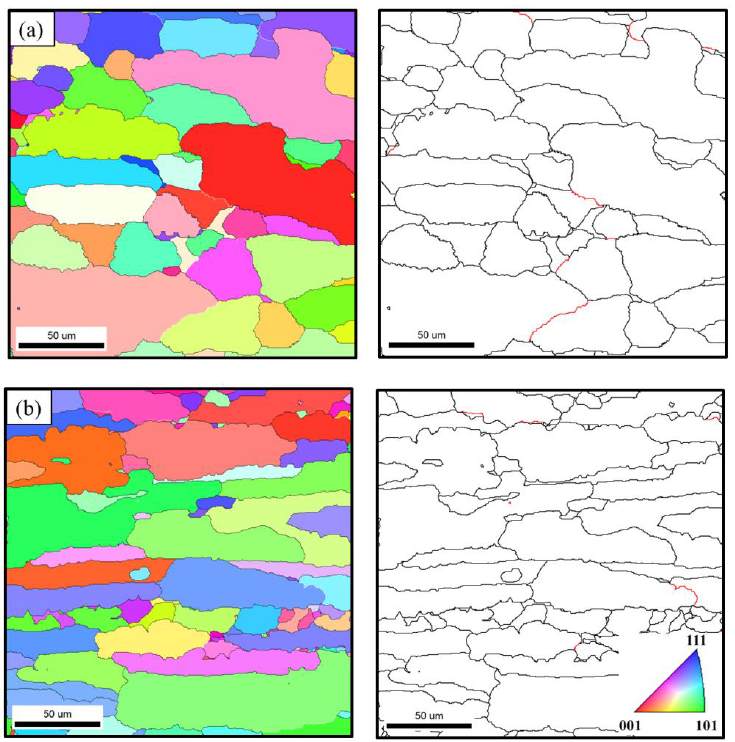
Figure 10. IPF coloring OIM maps relative to rolling direction (RD) and the grain boundary maps with high angle grain boundaries (HAGBs) > 15 in black lines and low angle boundaries (LAGBs) < 15 in red lines, ( a ) AA2024-T4 and ( b ) AA7075-T6.